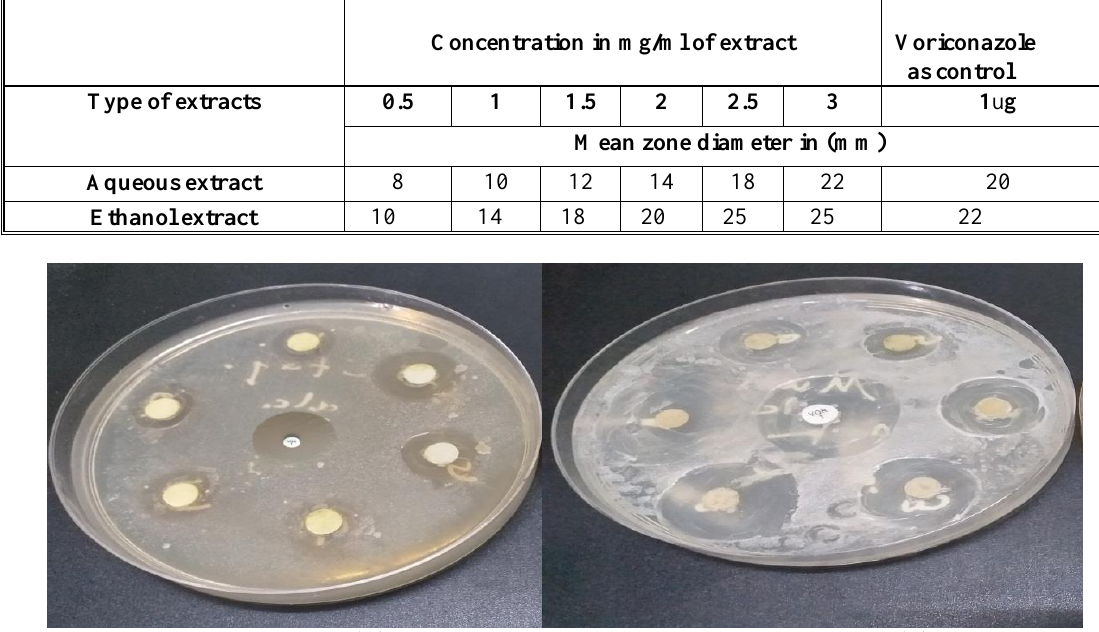
Table 4. The mean diameter of inhibition zone in millimeter against different concentrations of both Ginkgo biloba extracts and voriconazole as a control.